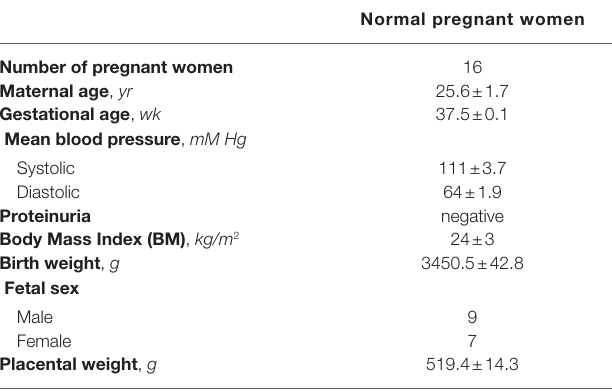
TABLE 1 | Characteristics of pregnant